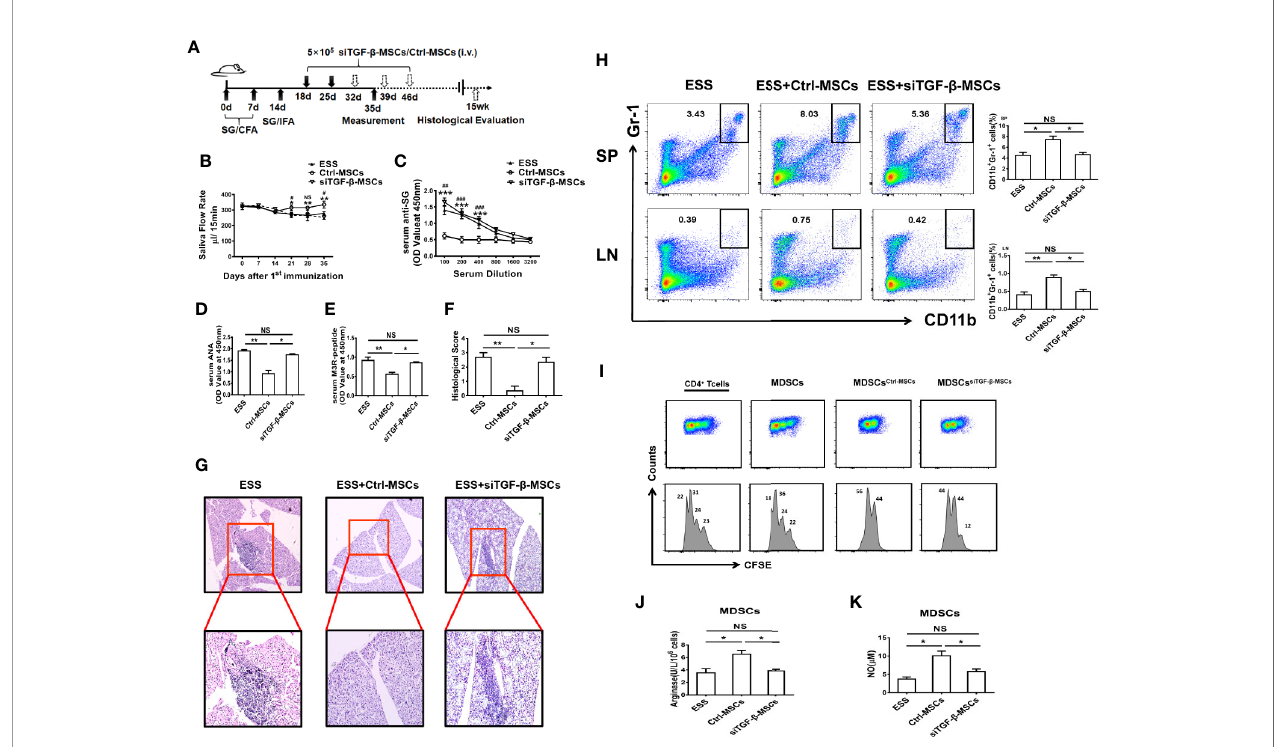
FIGURE 5 | Knocking down TGF- b in BM-MSCs impairs their capability in inhibiting ESS development. (A) Graphic scheme of ESS induction and MSCs treatment. BM-MSCs transfected with TGF- b siRNA (siTGF- b ) or negative control for 24 h, and then 5×10 5 siTGF- b -MSCs or Ctrl-MSCs were intravenously injected on days 18 and 25 after the fi rst immunization. Mice were sacri fi ced on day 35 (n=6). (B) The saliva fl ow rates were observed in each group. (C – E) Autoantibodies against SG antigens (C) , ANA (D) , and anti-M3R antibodies (E) were analyzed in the serum of mice with different treatment on day 35. (F, G) ESS mice were transferred with different BM-MSCs days 18, 25, 32, 39, and 46, the histological evaluation of glandular destruction in each group was performed on tissue sections of submandibular glands with H&E staining 15 weeks post fi rst immunization. (H) Percentages of MDSCs in spleen and LNs were measured in each group on day 35. (I) MDSCs from different groups were isolated on day 35, and then co-cultured with CD4 + T cells in the presence of anti-CD3 and anti-CD28 mAbs for 72 h (MDSC:T cell ratio 1:1). CD4 + T cell proliferation was evaluated by staining with CFSE. (J, K) The activity of arginase activity and the level of NO were detected in each group on day 35. Data are shown as mean± SD of three independent experiments, n=6/group. *** /### p < 0.001, ** /## p < 0.01, * /# p < 0.05, NS, no signi fi cance. * represents Ctrl-MSCs vs. siTGF- b -MSCs, # represents Ctrl-MSCs vs.